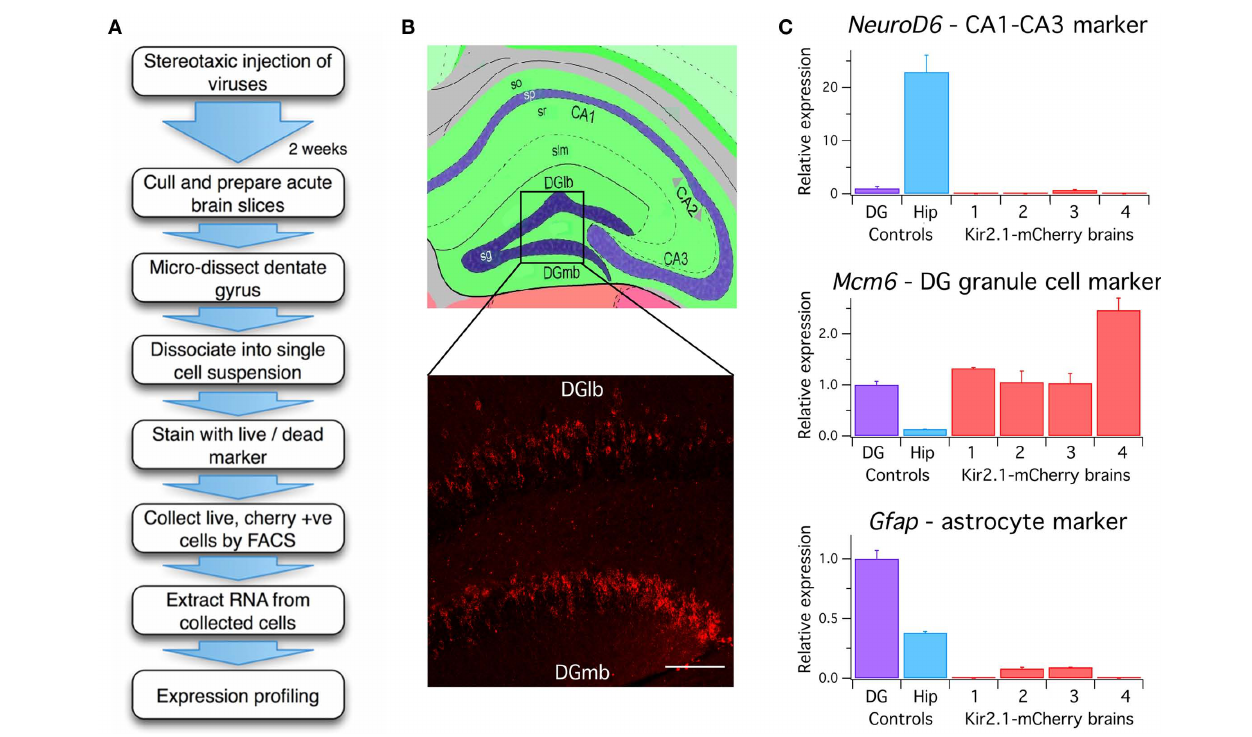
FIGURE 3 |Analysis of mRNA expression from dentate gyrus granule cells transduced in vivo . (A) Flow diagram of procedure for ex vivo isolation of virally transduced cells from the dentate gyrus. (B) Upper panel : Schematic of the hippocampus adapted from the Allen Mouse Brain Reference Atlas.Virus was injected into the dentate gyrus. Lower panel : Expression of Kir2.1-mCherry in granule cells (sg) of the dentate gyrus lateral blade (DGlb) and medial blade (DGmb). Scale bar = 100 μ m. (C) RT-PCR quantification of gene expression in Kir2.1-mCherry